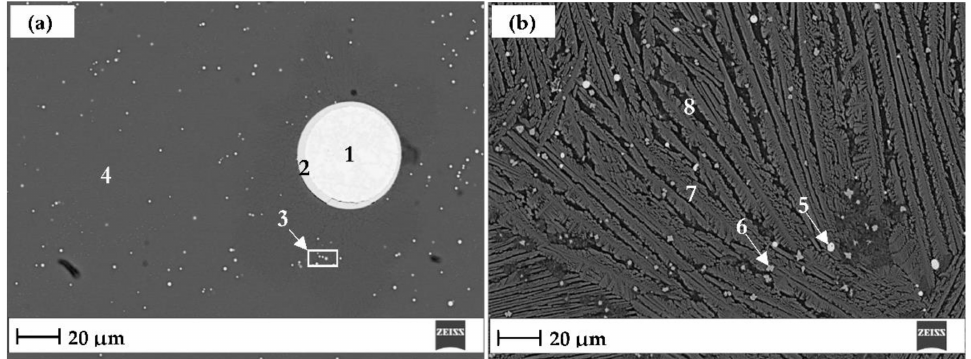
Figure 4. SEM images of slag from level 5 in batch T1 at: ( a ) the settling start (1L5_T1) where the phase labeled as “1” is speiss, “2” is matte, “3” is the slag phase with copper inclusions, and “4” the slag phase; ( b ) the settling end (2L5_T1) where “5” is a matte droplet, “6” the chromium spinel, and “7” and “8” the slag